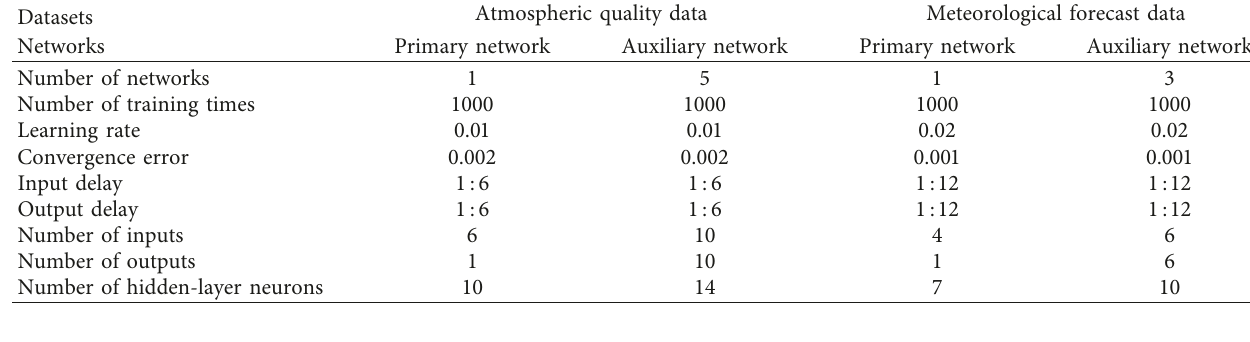
Table 2: Parameters of the network structure and